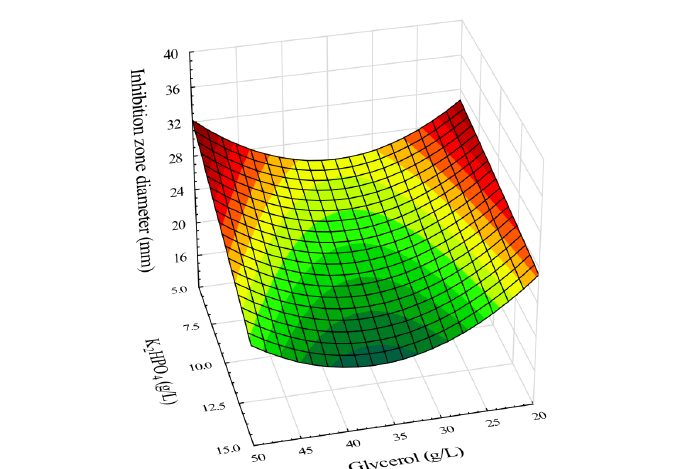
FIGURE 4 - The effects of glycerol and K content of 2